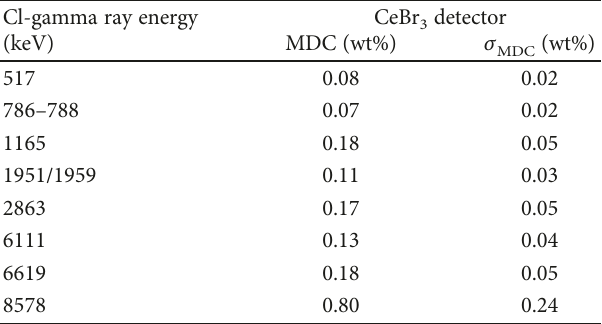
Table 2: Minimum detectable concentration (MDC) of chlorine in water samples for various gamma rays using CeBr with portable neutron generator-based PGNAA